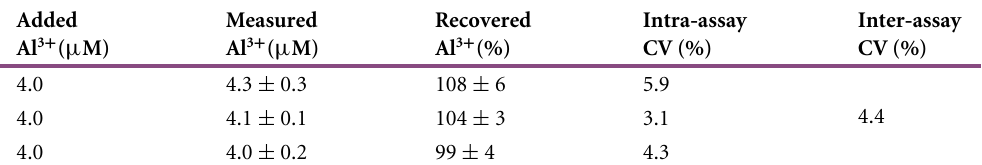
Table 4 Repeatability of the rutin-based colorimetric assay for Al 3 + ions across 3 plates with n = 60 replicates per